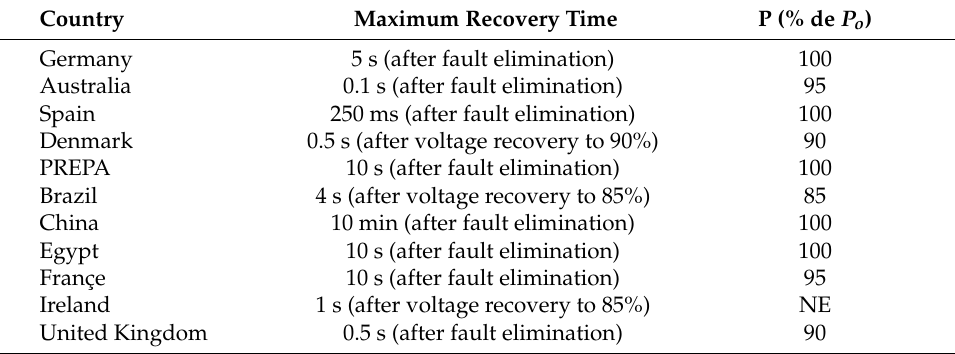
Table 5. Active power recovery thresholds after fault